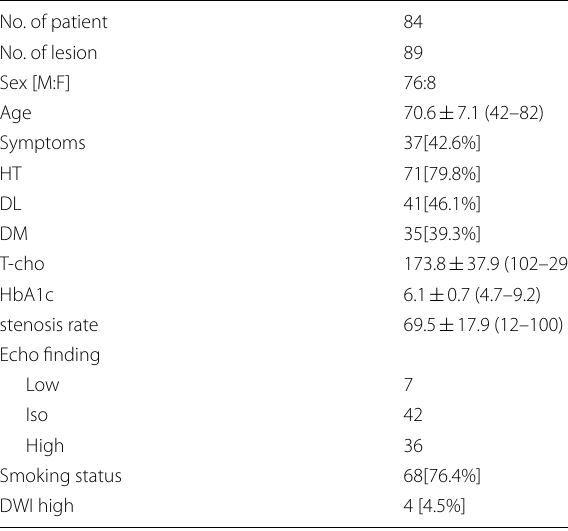
Table 1 Summary of cases